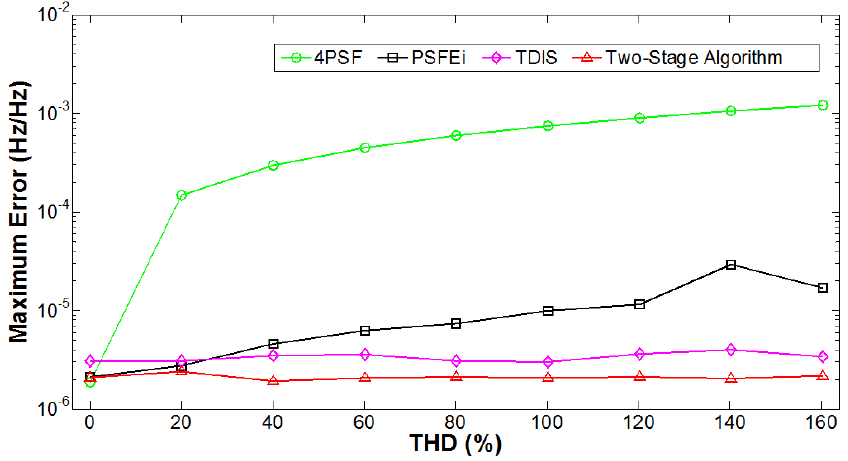
Figure 4. Maximum error of frequency estimation with increasing